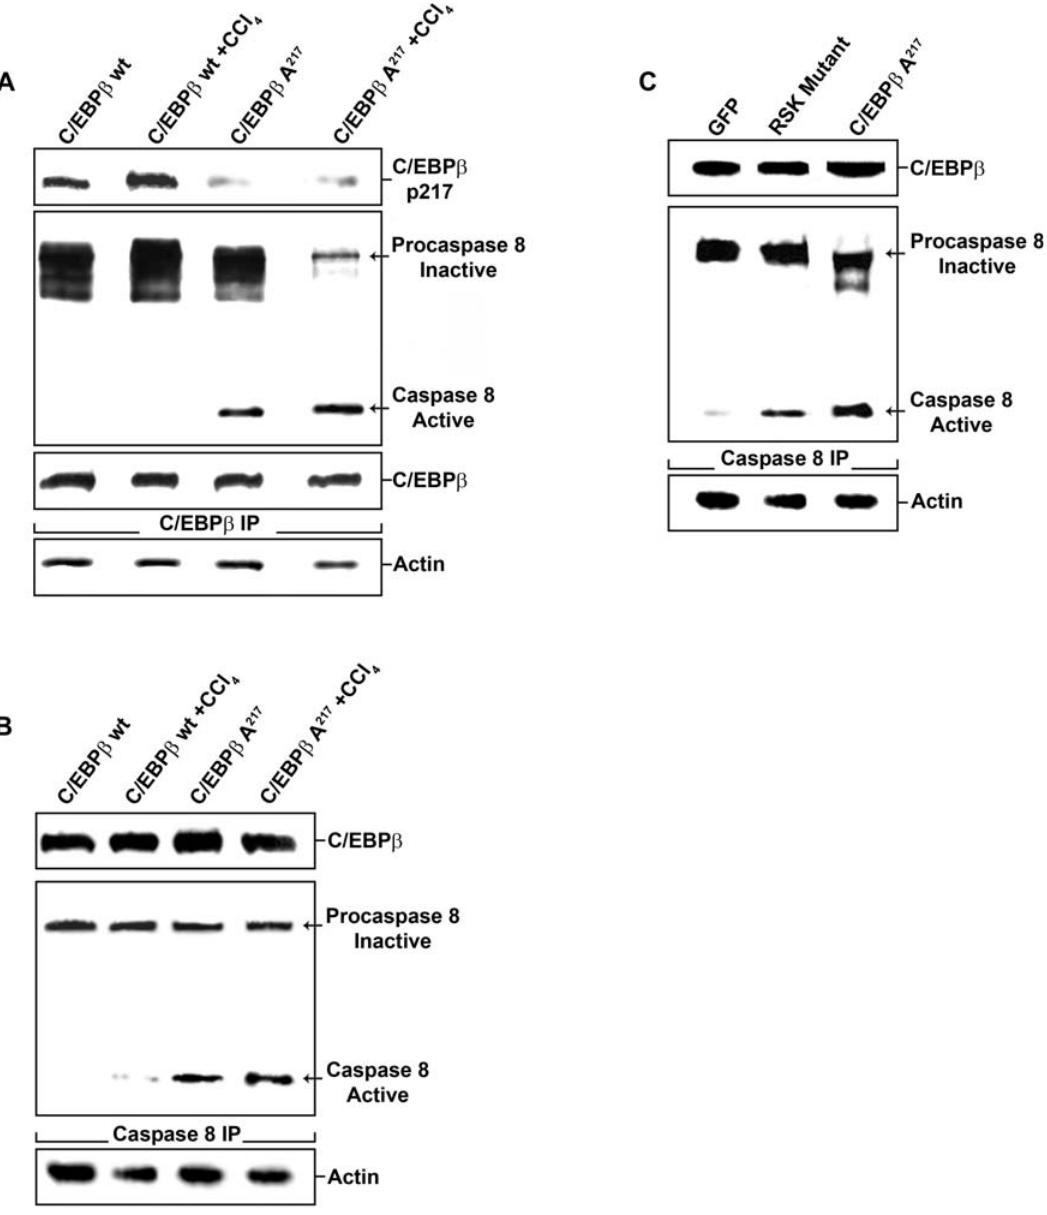
Figure 6. C/EBP b -Ala217 associates with active caspase 8 in hepatic stellate cells. A. A caspase 8 immunoblot was performed on C/EBP b immunoprecipitates from protein lysates from samples described in (Fig 5 A). The association between C/EBP b -Ala217 with active caspase 8 was increased in HSC isolated from C/EBP b -Ala217 mice. Phosphorylated C/EBP b -Thr217 was decreased in HSC from C/EBP b -Ala217 mice treated with CCl 4 . C/EBP b and RSK were similar in the different experimental groups. b -Actin was used as an internal control for the immunoprecipitations. B. Reciprocal caspase 8 immunoprecipitation of experiment described in (A) confirmed the association of C/EBP b -Ala217 with active caspase 8. b -Actin was used as an internal control for the immunoprecipitations. C. Reciprocal caspase 8 immunoprecipitation of experiment described in ( Figure 5C ), confirmed the association of C/EBP b -Ala217 with active caspase 8. b -Actin was used as an internal control for the